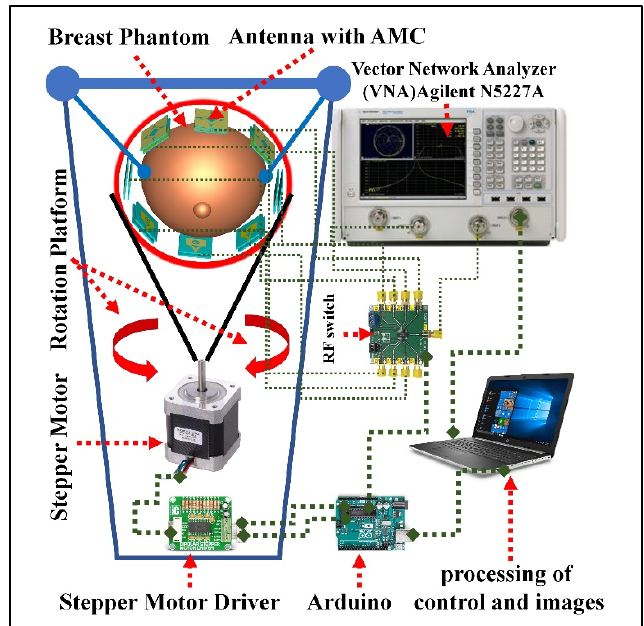
Figure 19. The breast imaging system presented is shown in schematic form with its many ele-